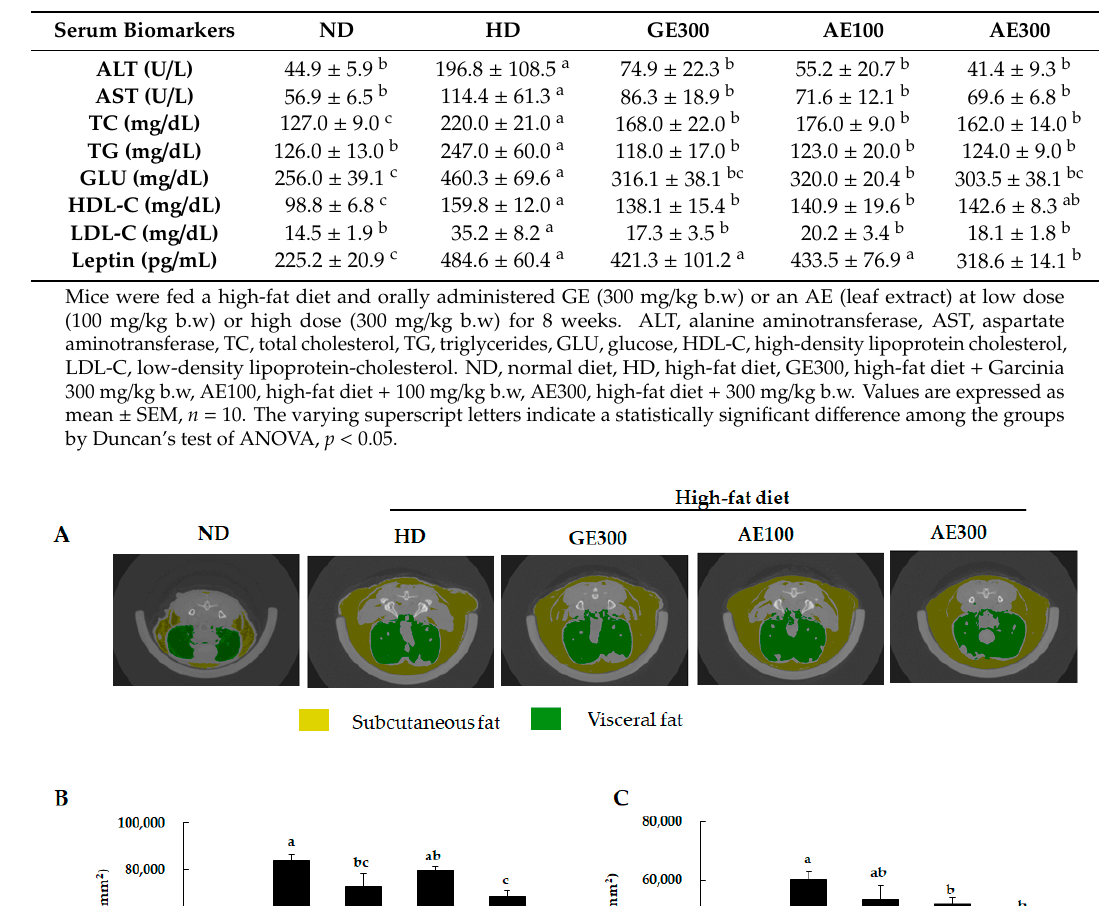
Table 2. E ff ect of AE on serum biochemical parameters in the experimental mice.